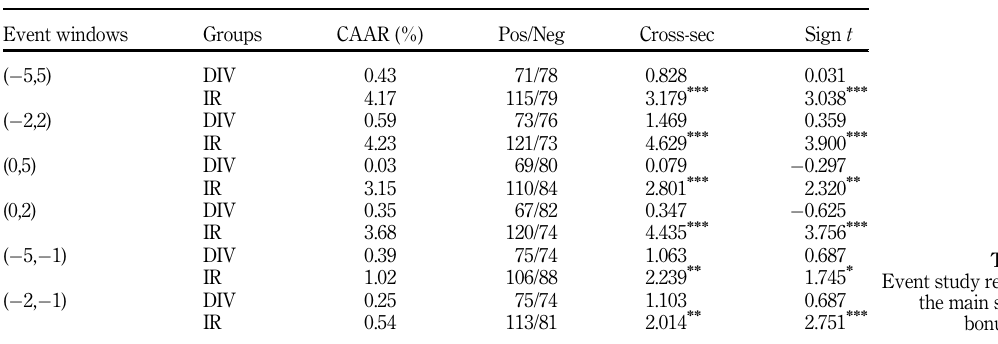
Table 2. Event study results for